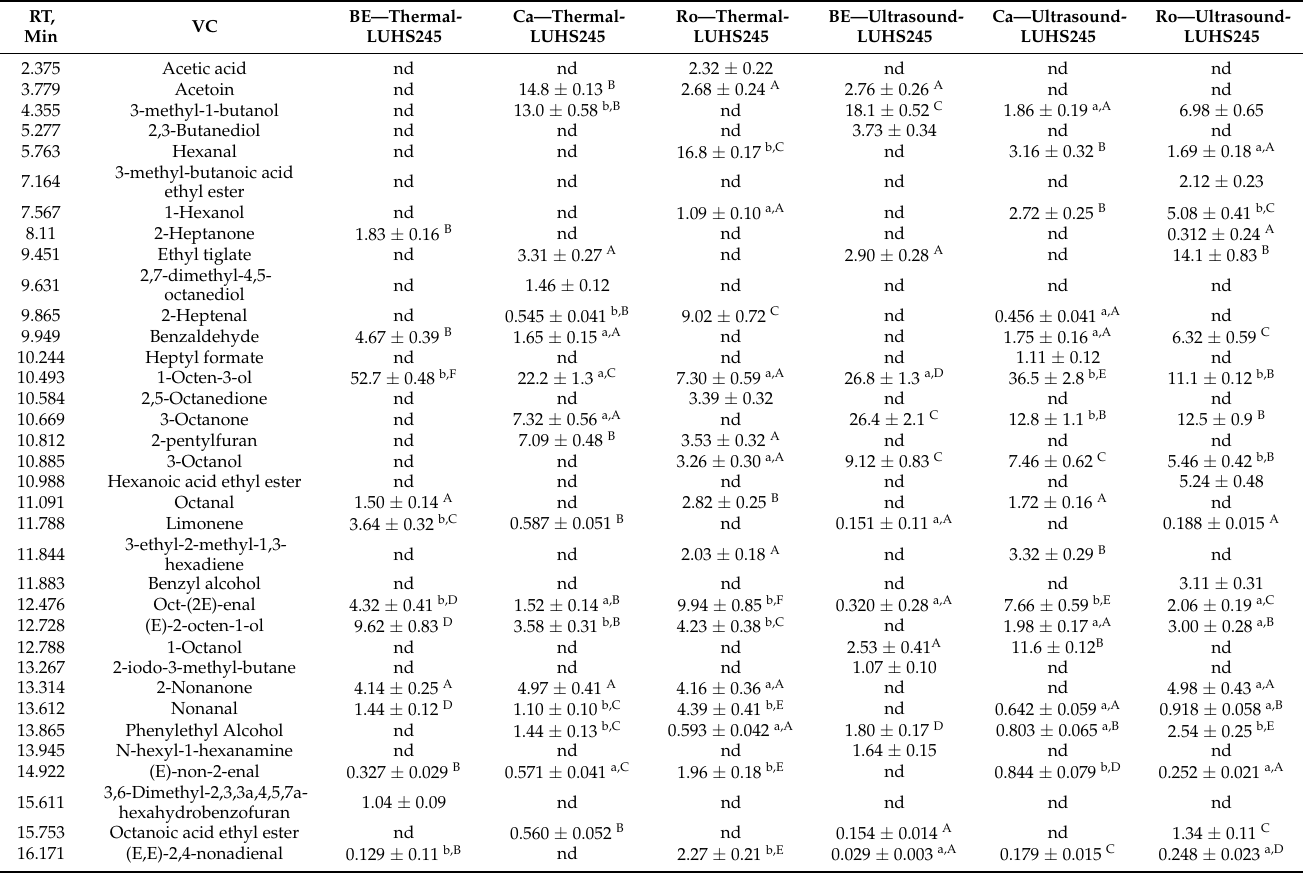
Table 4. Volatile compound profile of thermal treated and ultrasonicated fermented edible